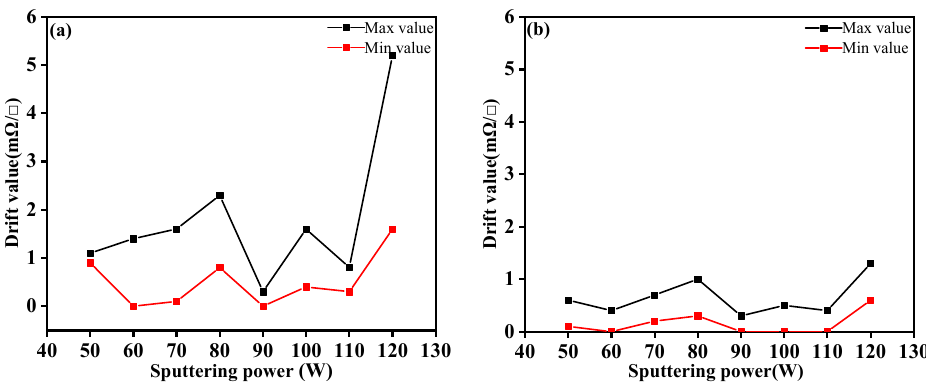
Figure 6. ( a ) Drift value of Ag layers before heat treatment at specific sputtering powers; ( b ) Drift value of Ag layers after heat treatment at specific sputtering powers.